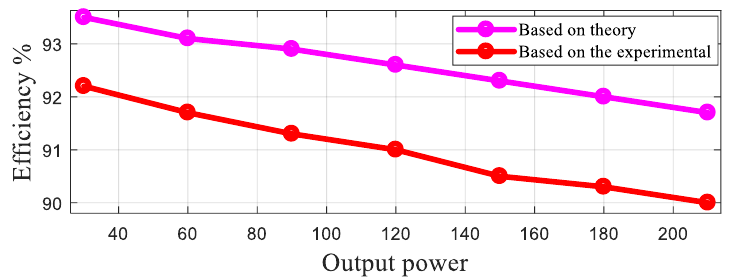
Figure 15. The efficiency of the proposed converter for the various value of the output power and 50 percent of the duty cycle.